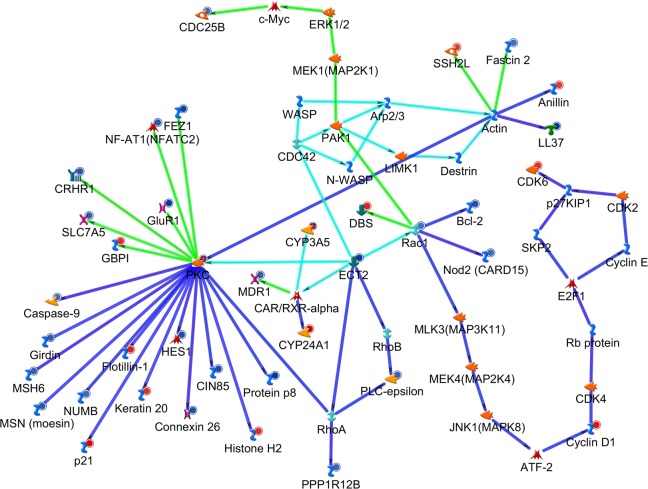
Network analysis suggests a more robust senescence phenotype is induced in the presence of activating KRASG13D mutation.Signalling network built out from ECT2 as a seed object using the Shortest Paths algorithm in GeneGo from Metacore. Gene expression data from HCT116 parental and HCT116 KRAS+/- cells was overlaid on this network. Green lines represent HCT116 parental-specific paths, dark blue represent HCT116 KRAS+/- specific paths, light blue represent common paths. Red circles next to icons reflect up-regulation, while blue circles reflect down-regulation in expression profiles. Shading intensity indicates fold change (minimum 2-fold). Icons indicate protein functional classes.